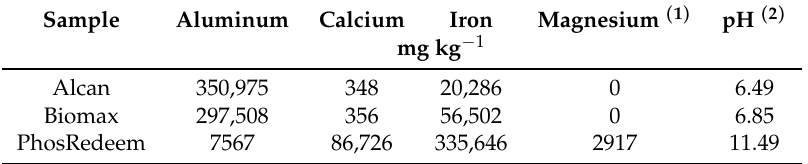
Table 1. Chemical characterization of PSMs: Average elemental composition and